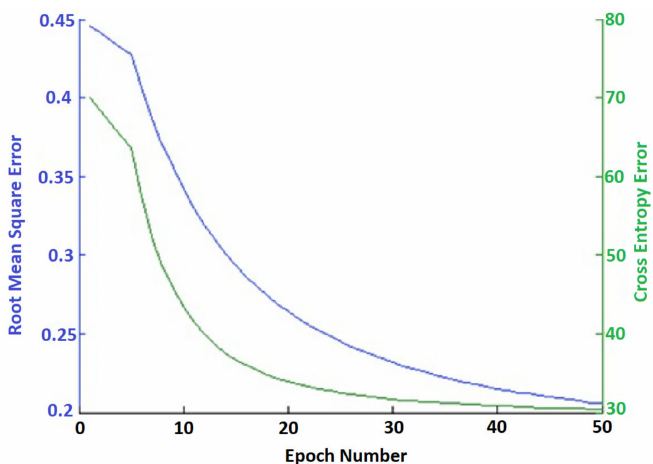
Figure 14. Root mean square error and cross-entropy error—training curve for the DBN developed with 21 inputs, 50 neurons in the first hidden layer, 50 neurons in the second hidden layer, 50 neurons in the third hidden layer, and 3 output neurons.